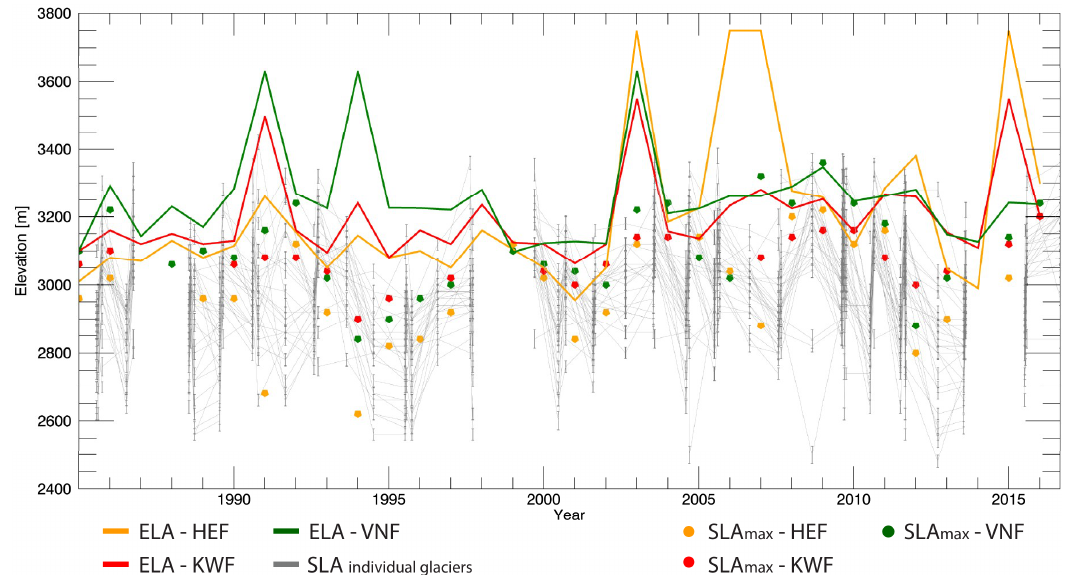
Figure 6. Snow cover ratio (SCR) for all glaciers (grey lines connecting one SCR value with the following one) within the >30 years study period. Colored points mark the minimum SCR for HEF, KWF and VNF for the respective season. The accumulation area ratio (AAR) values derived in the field for the three glaciers are shown as lines.